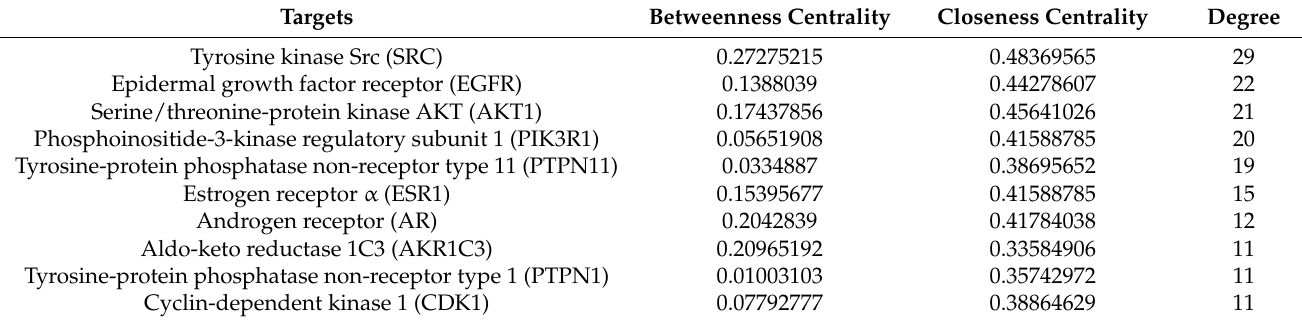
Table 4. Topological analysis of the protein-protein interaction of RSBDP against IBD (Top 10).